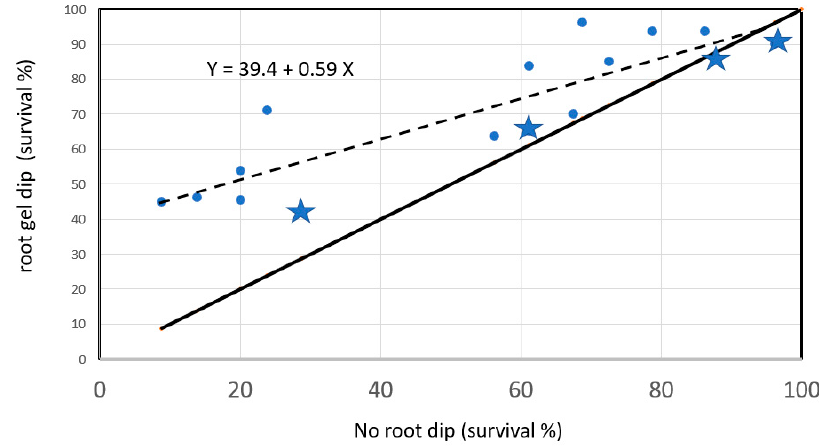
Figure 13. Effect of applying a gel root-dip on survival of bareroot red pine seedlings ( Pinus resinosa Ait.) and jack pine ( Pinus banksiana Lamb.) [88]. Seedlings not exposed to the sun are represented by stars, while the remaining dots were exposed to the sun for 5, 10 or 20 min prior to planting. Points above the solid line represent sites where the root gel increased survival. p > |t| = 0.0001 for intercept and 0.0001 for slope; R 2 = 0.77.